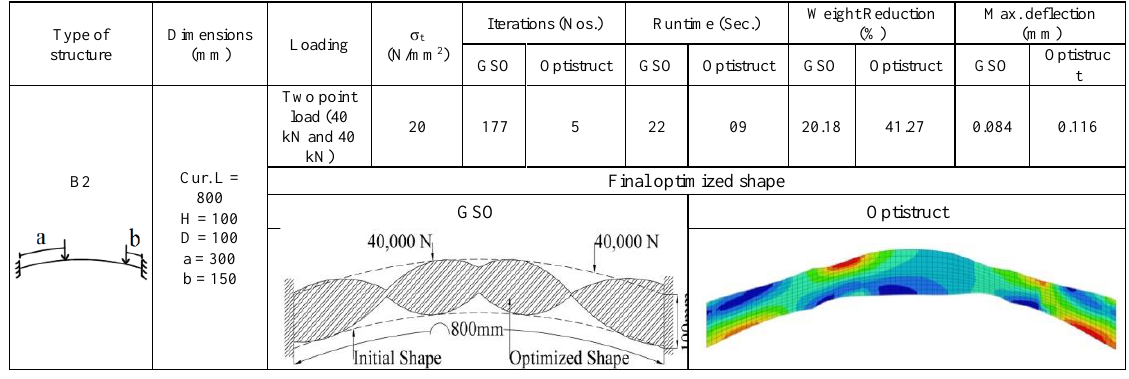
Table 2. Parameters for B2 with iterations, runtime and percentage weight reduction to reach the optimized shape.